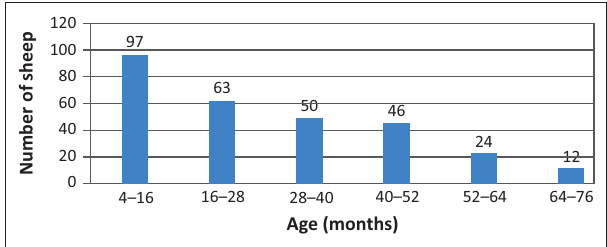
FIGURE 1: Age distribution of study